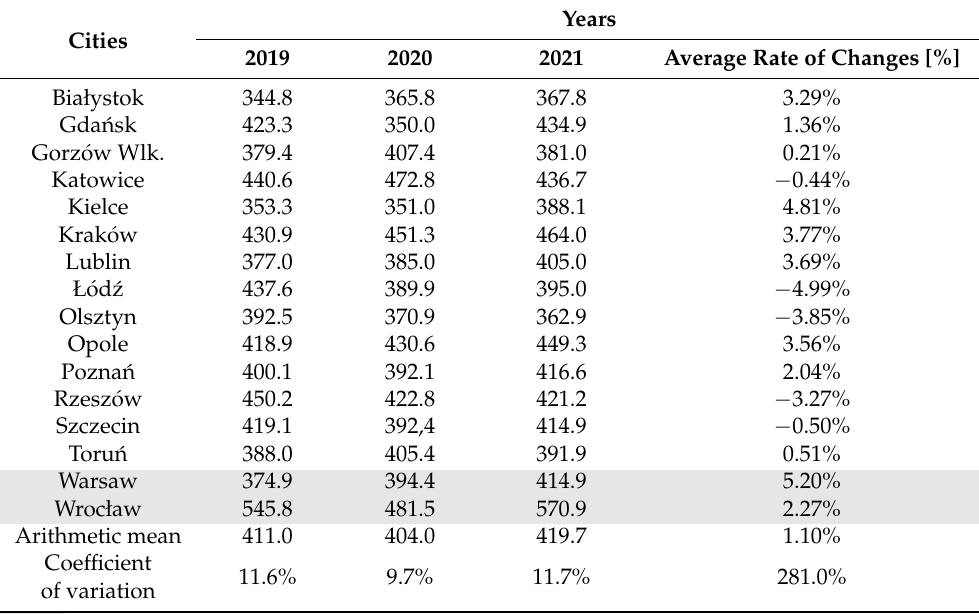
Table 2. Volume and average rate of change of municipal waste generated in the studied cities from 2019 to 2021 [in kg/inhabitant].